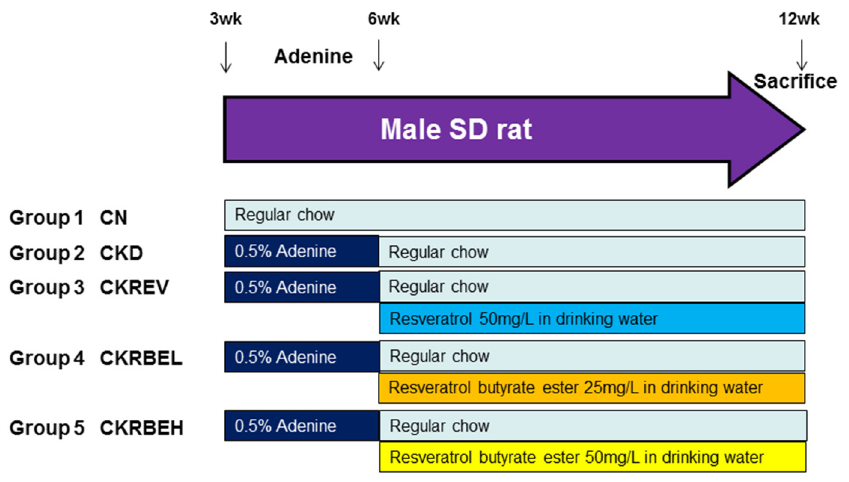
Figure 1. Experimental protocol used in the present study.